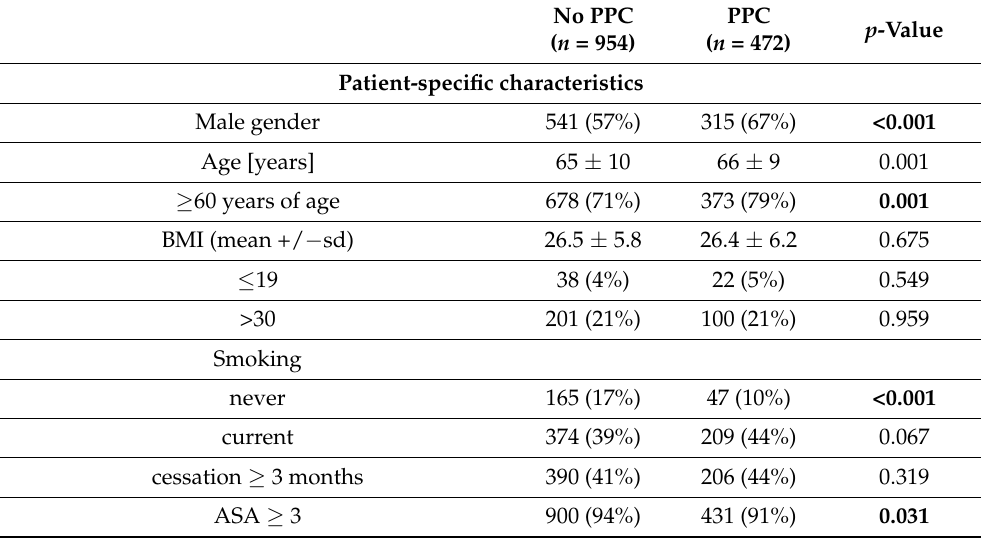
Table 1. Univariate analysis of patient-specific preoperative characteristics that led to risk factors for PPCs in patients undergoing open thoracotomy lung resection due to primary lung cancer. The data are presented as the number of patients (percentage) or median ( ± interquartile range). PPC =